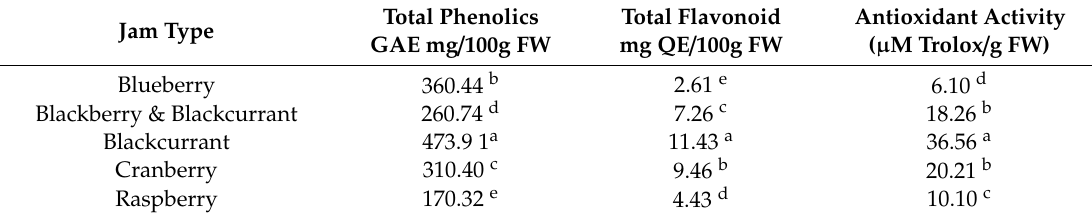
Table 2. Total phenolics, flavonoids, and antioxidant activity of the five berry